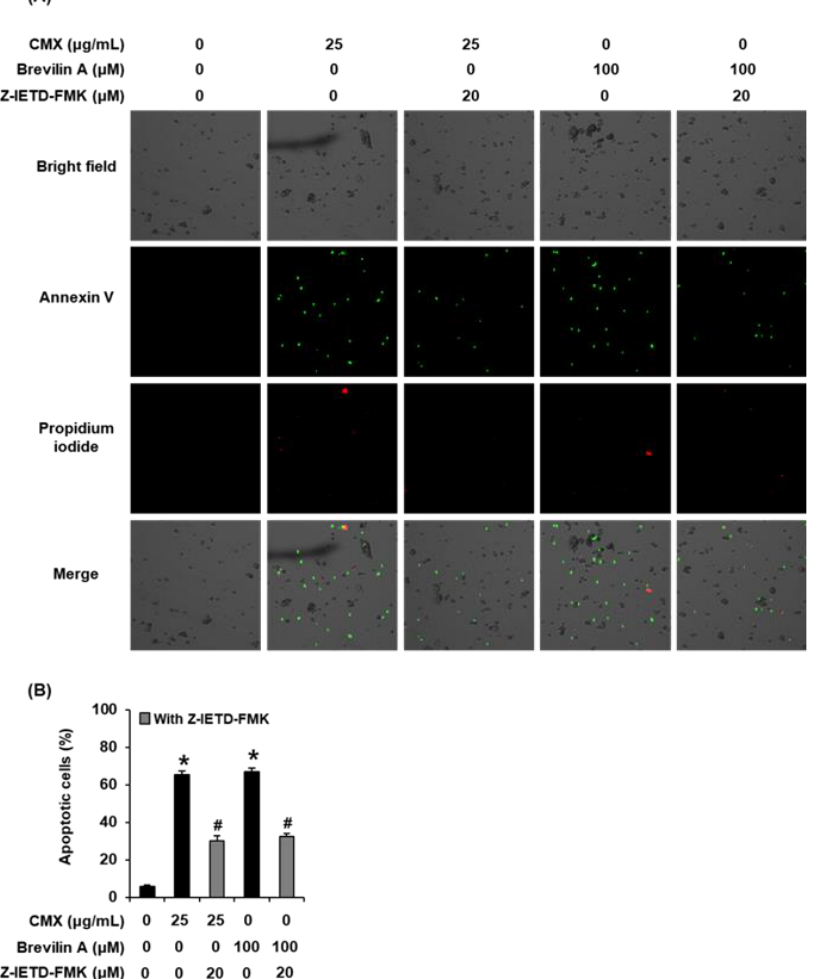
Figure 8. The effects of Centipeda minima (CMX), brevilin A, and Z-IETD-FMK (a caspase-8 inhibitor) on apoptotic cell death in AGS human gastric cancer cells. ( A ) Representative images of apoptotic cells stained with annexin V (green) and propidium iodide (red) were obtained using a Tali Image-Based Cytometer. ( B ) The experiment was performed in triplicate. The error bars represent the standard deviation of samples (n = 3). * p < 0.05 compared with that of the control. # p < 0.05 difference with Z-IETD-FMK group.